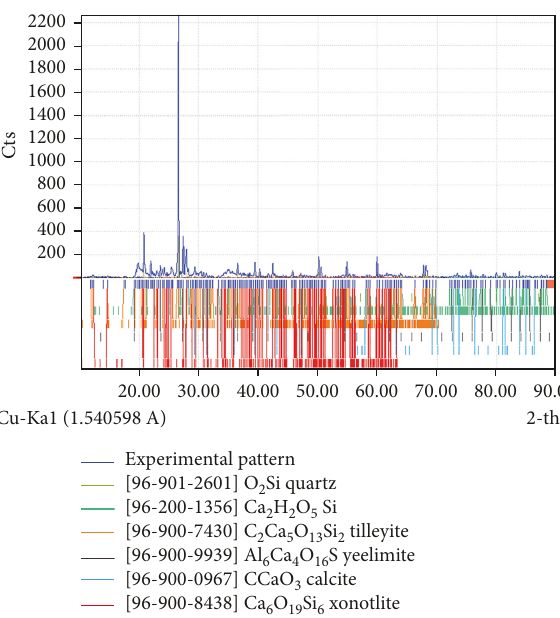
Figure 9: Mineralogy of stabilized soil with lime, jaggery, and gallnut